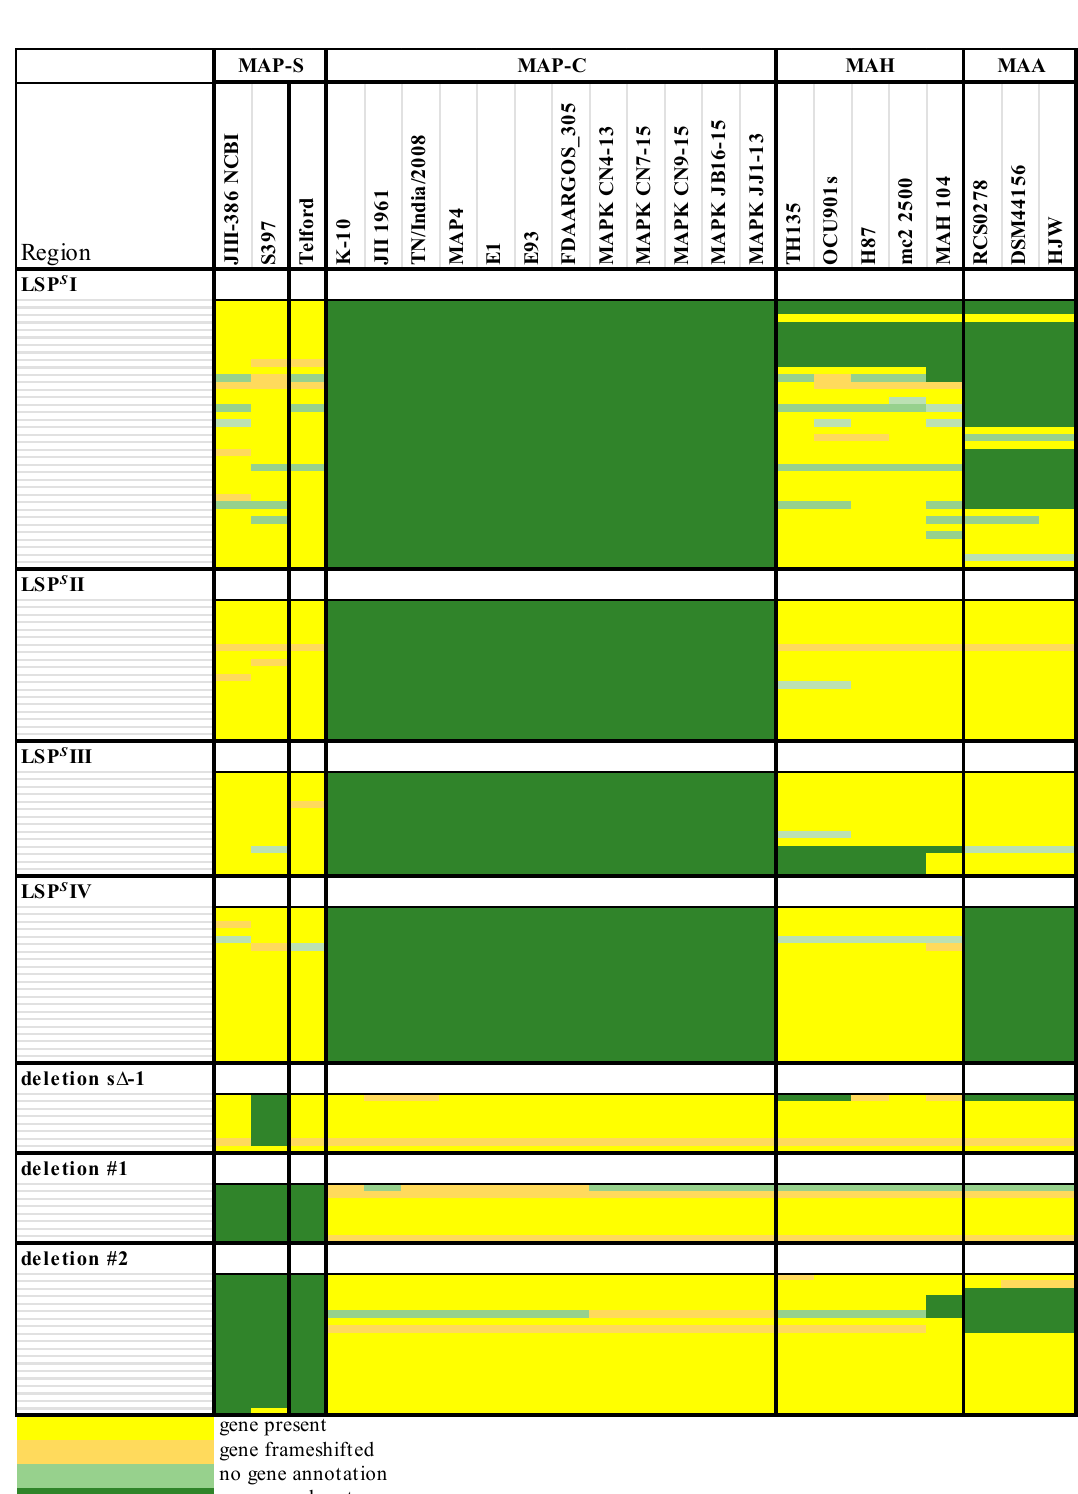
Figure 8. Presence and absence of genes belonging to MAP-S specific LSP S s I–IV and predicted deletions within 23 different Mycobacterium avium complex (MAC) genomes belonging to MAP-S, MAP-C, MAH and MAA. All protein coding genes (CDS) belonging to these regions and their predicted functions are presented in Table S10.